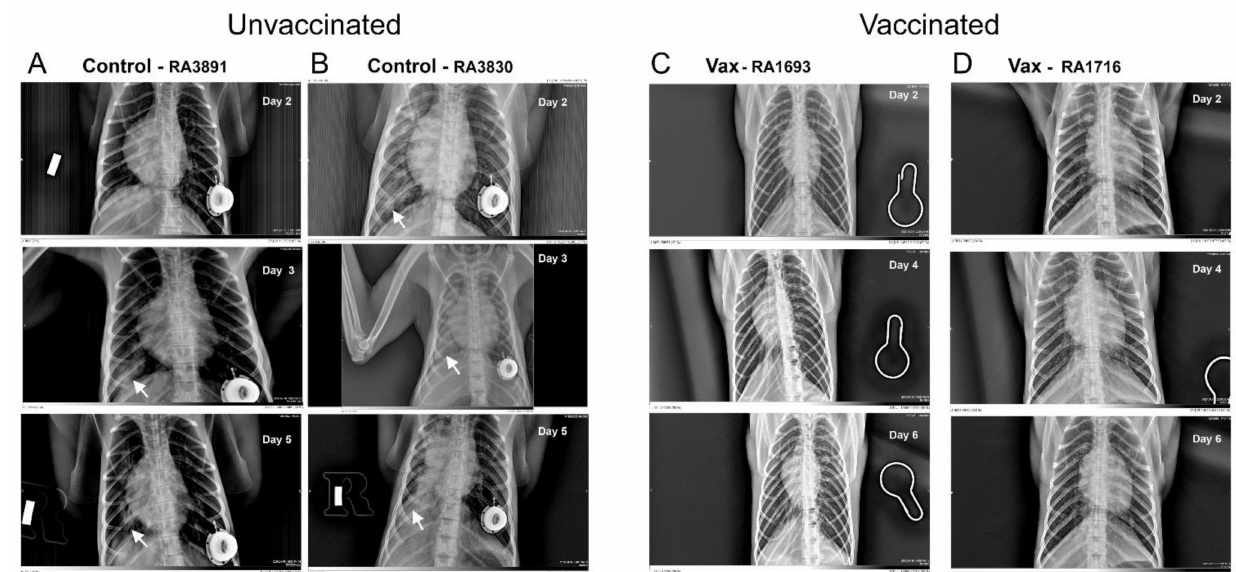
Figure 4. Representative chest radiographs of control and vaccinated macaques following SARS-CoV-2 challenge. As shown, control macaques (left columns ( A , B )) demonstrated a progression of pulmonary infiltrates during the acute period (days 2–5) of disease post-challenge. In contrast, vaccinated macaques (right columns ( C , D )) lacked similar abnormalities. White arrows indicate areas of mild-to-moderate pulmonary infiltrates seen as ground-glass